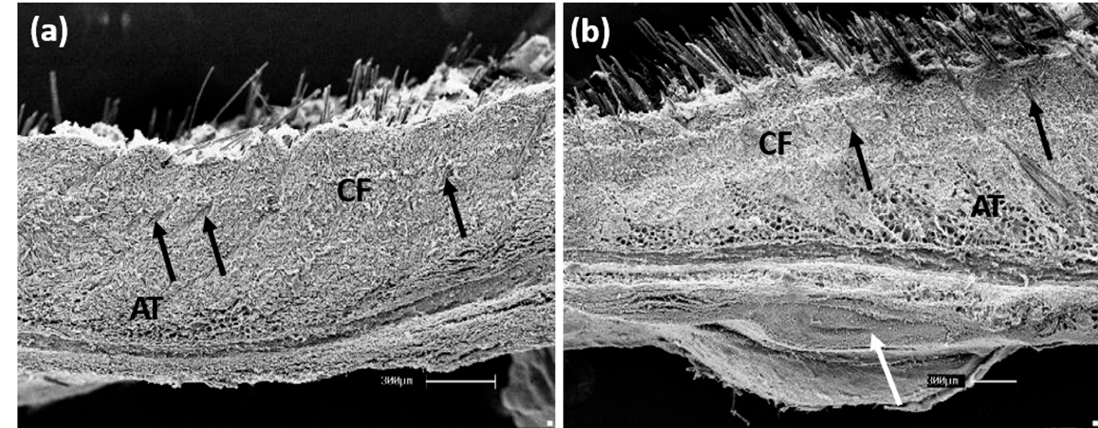
Figure 6. Scanning electron microscopy (control animal), with collagen fibers (CF), adipose tissue (AT) and hair follicles (arrows), bar: 300 µm, ( a ); Skin with GO indicating collagen fibers (CF), adipose tissue (AT), the hair follicle (black arrow) and GO layer (white arrow), scale bar: 300 µm, ( b ).